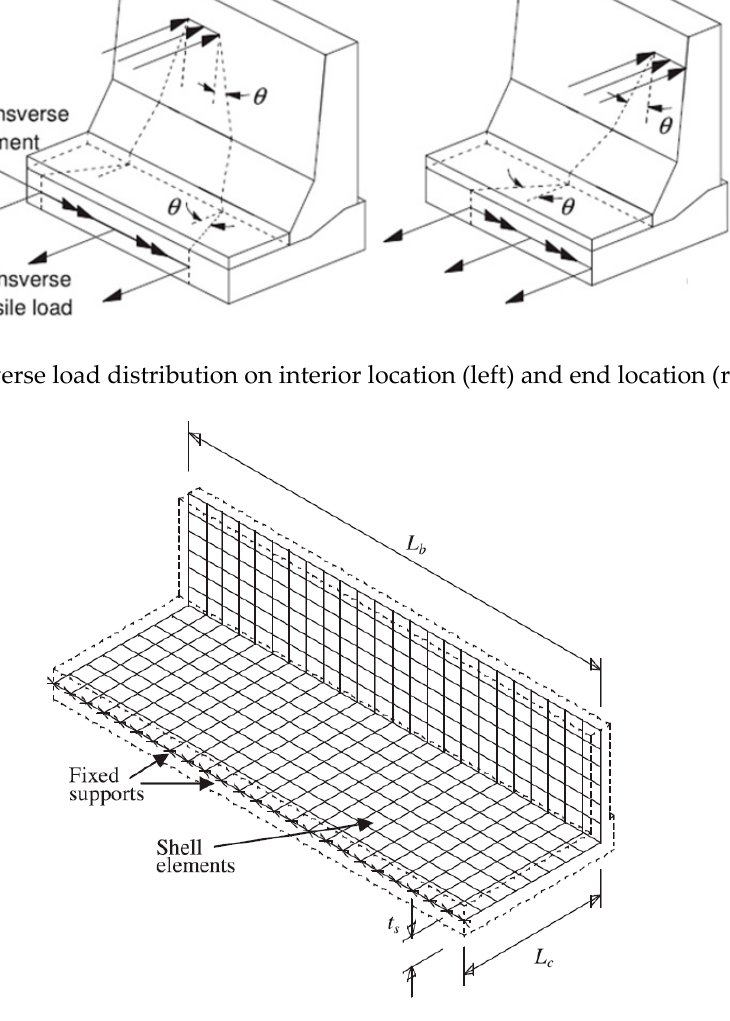
Figure 30. Finite element model and applied transverse loading. ( a )Transverse load distribution on interior location ( left ) and end location ( right ). ( b ) Typical finite element model and notations used for the parametric study [18].